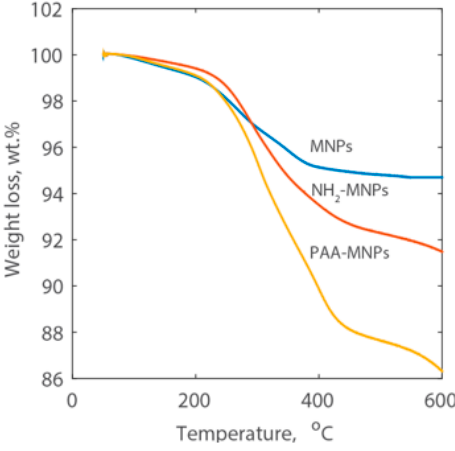
Figure 3. TGA curves of MNPs, NH 2 -MNPs, and PAA-MNPs.